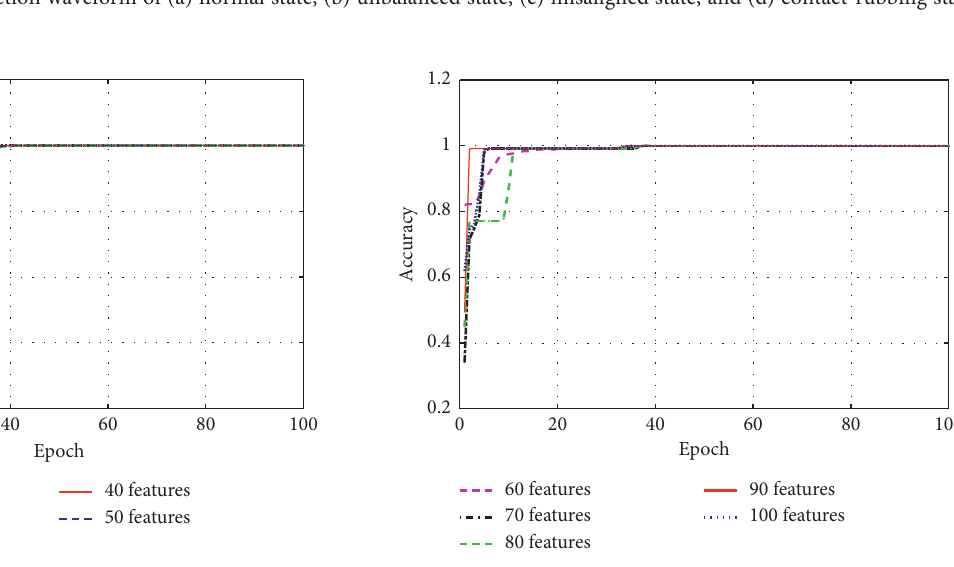
Figure 7: Wavelet reconstruction waveform of (a) normal state, (b) unbalanced state, (c) misaligned state, and (d) contact-rubbing state.